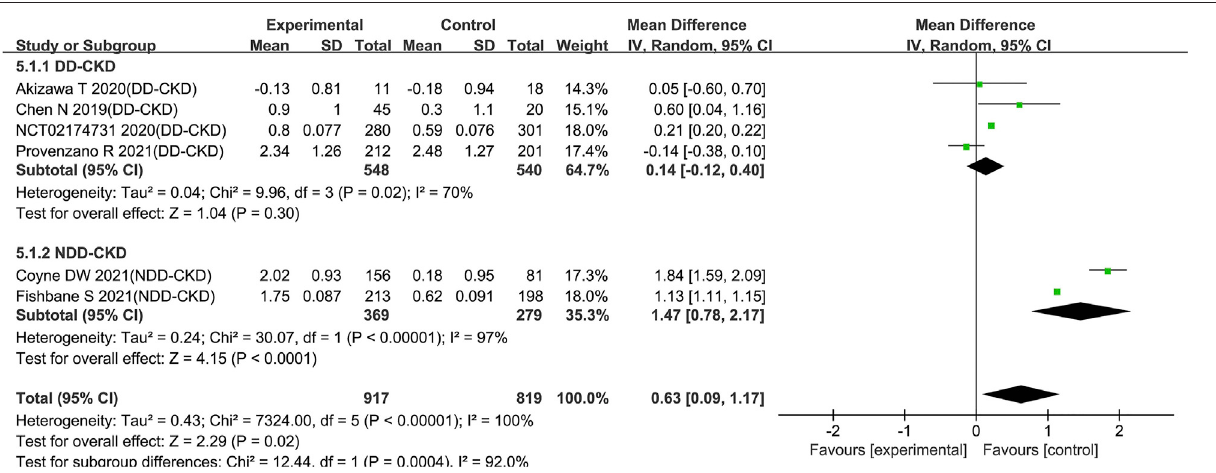
FIGURE 5 | Effect of roxadustat compared with ESA or placebo on Hb level with elevated CRP levels in CKD patients. Notes: CKD, chronic kidney disease; DD- CKD, dialysis-dependent chronic kidney disease; NDD-CKD, non-dialysis-dependent chronic kidney disease; CRP, C-reactive protein.